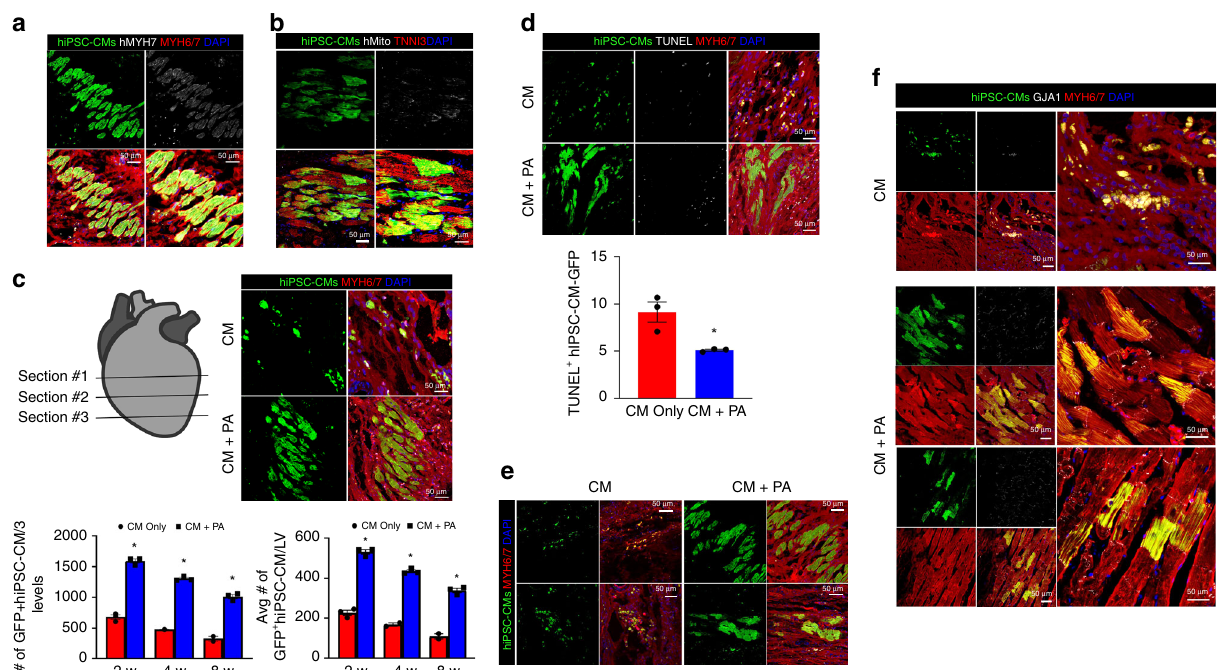
Fig. 4 Implantation of hMSC-PA improves the retention and maturation of hiPSC-CMs on the infarcted myocardium. a Representative immunostaining images with hiPSC-CM-GFP (green), human speci fi c MYH7 (gray), and MYH6/7 (red). Expression of hMYH7 in the hiPSC-CM-GFP verify the identity of hiPSC-CM-GFP as human CMs. Scale bars: 50 μ m. b Representative immunostaining images with hiPSC-CM-GFP (green), human-speci fi c mitochondria (gray), and MYH6/7 (red). c Quanti fi cation of hiPSC-CM-GFP remained in the hearts receiving CM or CM + PA. The heart tissue sections at three different locations were prepared and then immunostained with the MYH6/7 antibody. Subsequently, we imaged entire left ventricle (LV) area at three different locations of heart sections and manually counted the hiPSC-CMs positive for both GFP signal (green) and MYH6/7 antibody (red). Representative immunostaining images with hiPSC-CM-GFP (green) and MYH6/7 (red) and their quanti fi cation results. The data are represented as mean ± SEM. * p < 0.05 compared with CM only group. T test was used for statistical analyses. n = 3 biologically independent samples per group. d Results of TUNEL assay performed to assess the alive hiPSC-CM-GFP in the hearts receiving CM or CM + PA. The data are represented as mean ± SEM. *** p < 0.05 compared with CM group; n = 3 biologically independent samples per group. T test was used for statistical analyses. e Representative images of hiPSC-CM-GFP (green) expressing MYH6/7 (red) when they were injected in the absence or presence of hMSC-PA in MI hearts. Scale bars: 50 μ m. f Representative images of hiPSC-CM-GFP (green) expressing MYH6/7 (red) and GJA1 (gray) when they were injected in the absence or presence of hMSC-PA in MI hearts. Expression of GJA1 indicates integration of implanted hiPSC-CMs with host myocardium. Scale bars: 50 μ m. The heart sections were also stained with DAPI (blue) for visualization of nuclei. CM: hiPSC-CMs. CM + PA: hiPSC-CMs + hMSC-loaded